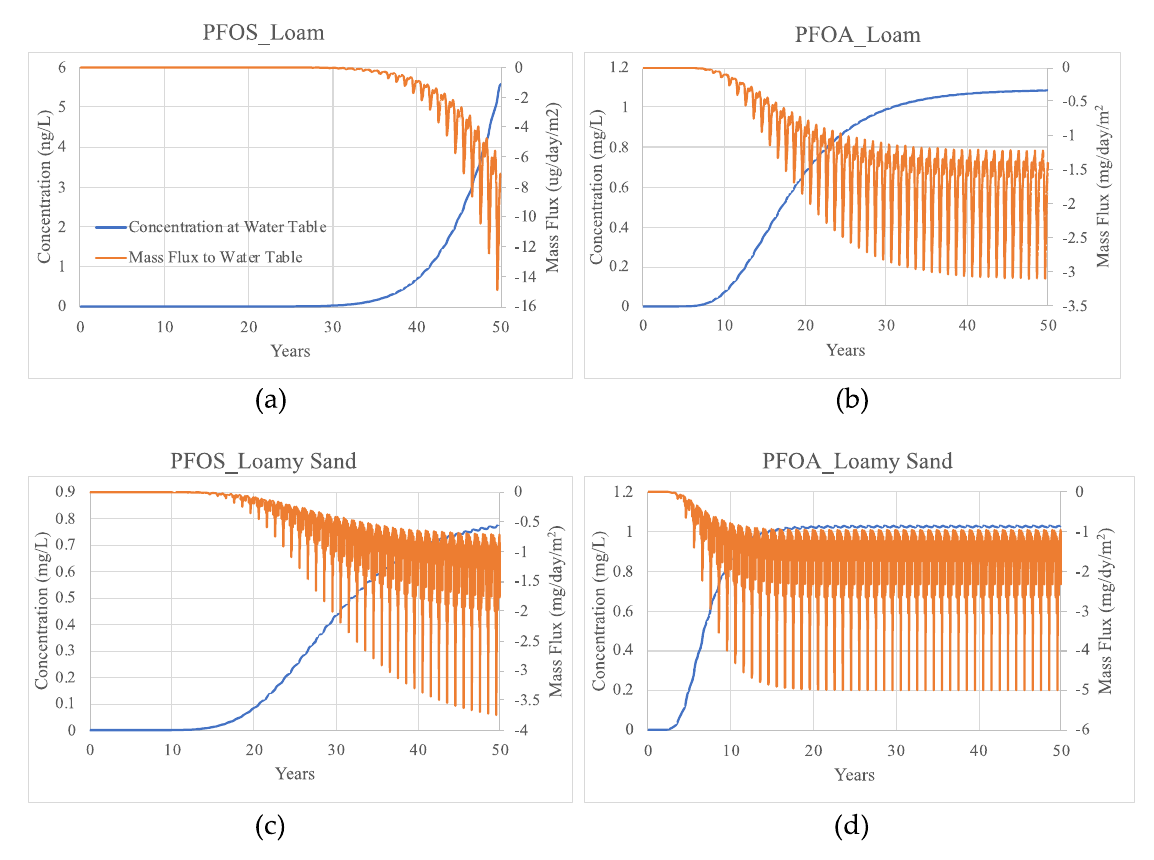
Figure 9. Pore-water concentration and mass flux of PFAS at the water table: ( a ) PFOS within loam; ( b ) PFOA within loam; ( c ) PFOS within loamy sand; ( d ) PFOA within loamy sand. Negative flux indicates flow out of the bottom of the simulation domain.